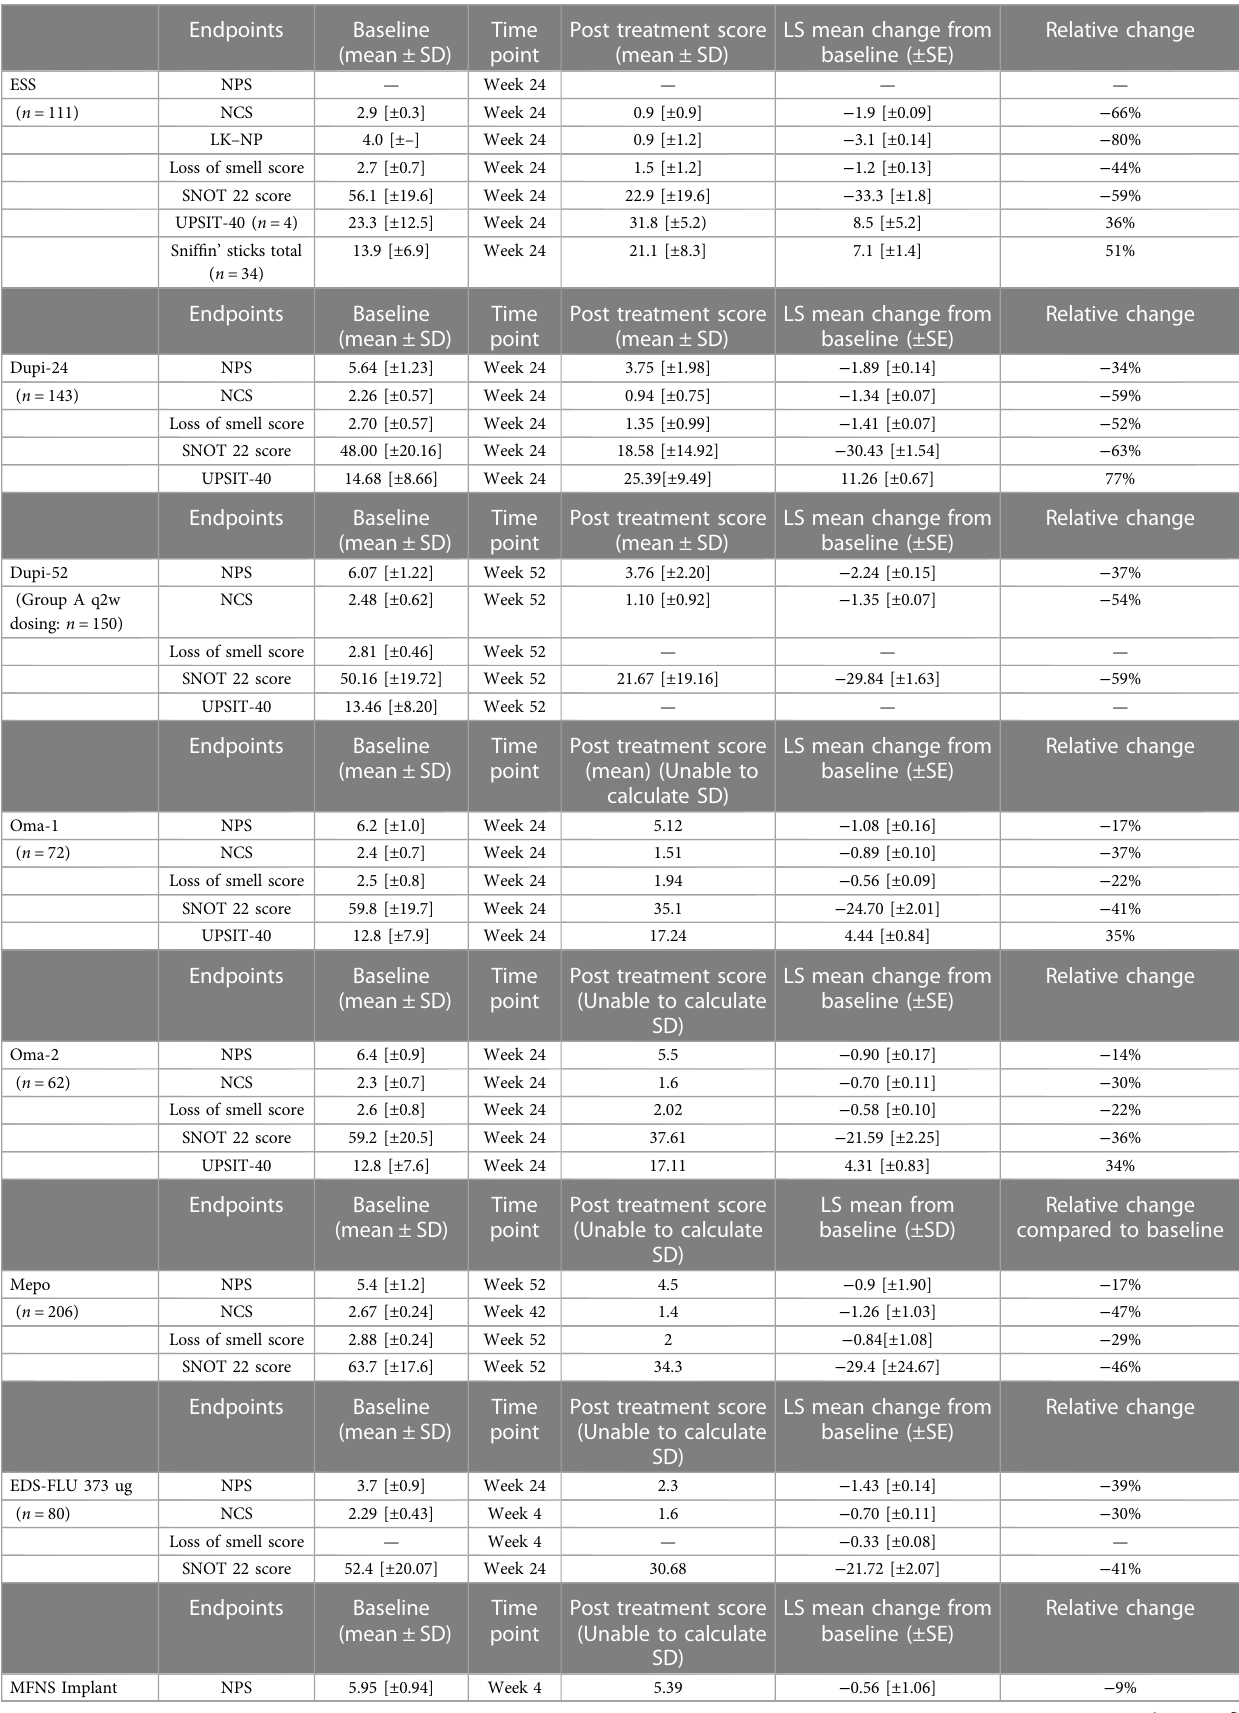
TABLE 4 CRSwNP treatment ef fi cacy based on randomized control clinical trial